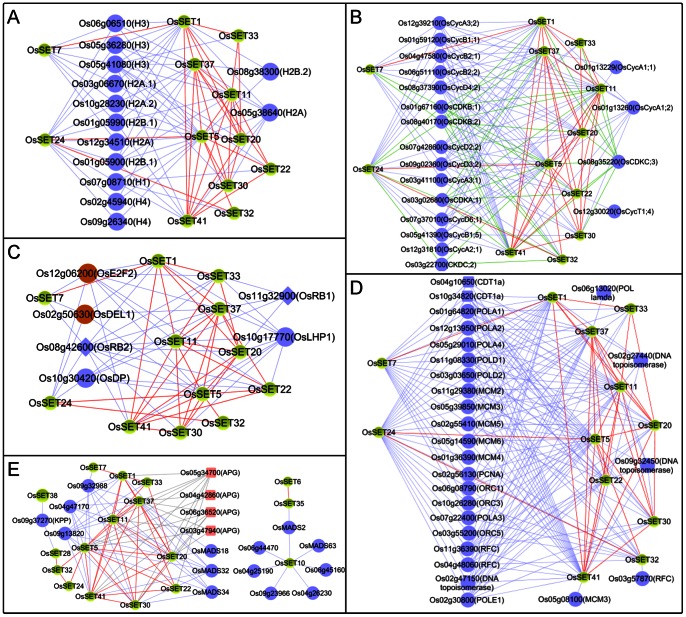
Co-expression network of OsSET genes.A. The co-expression relationship among OsSET genes and histone genes (H2A, H2B.1, H2B.2, H3 and H4). B. Network of OsSET genes and cell division related genes. C. Co-expression network of OsSET and RB-E2F/DB pathway genes. D. A co-expression network regarding the OsSET genes and DNA replication factors. E. A co-expression network concerning OsSET genes and genes involved in flower development.